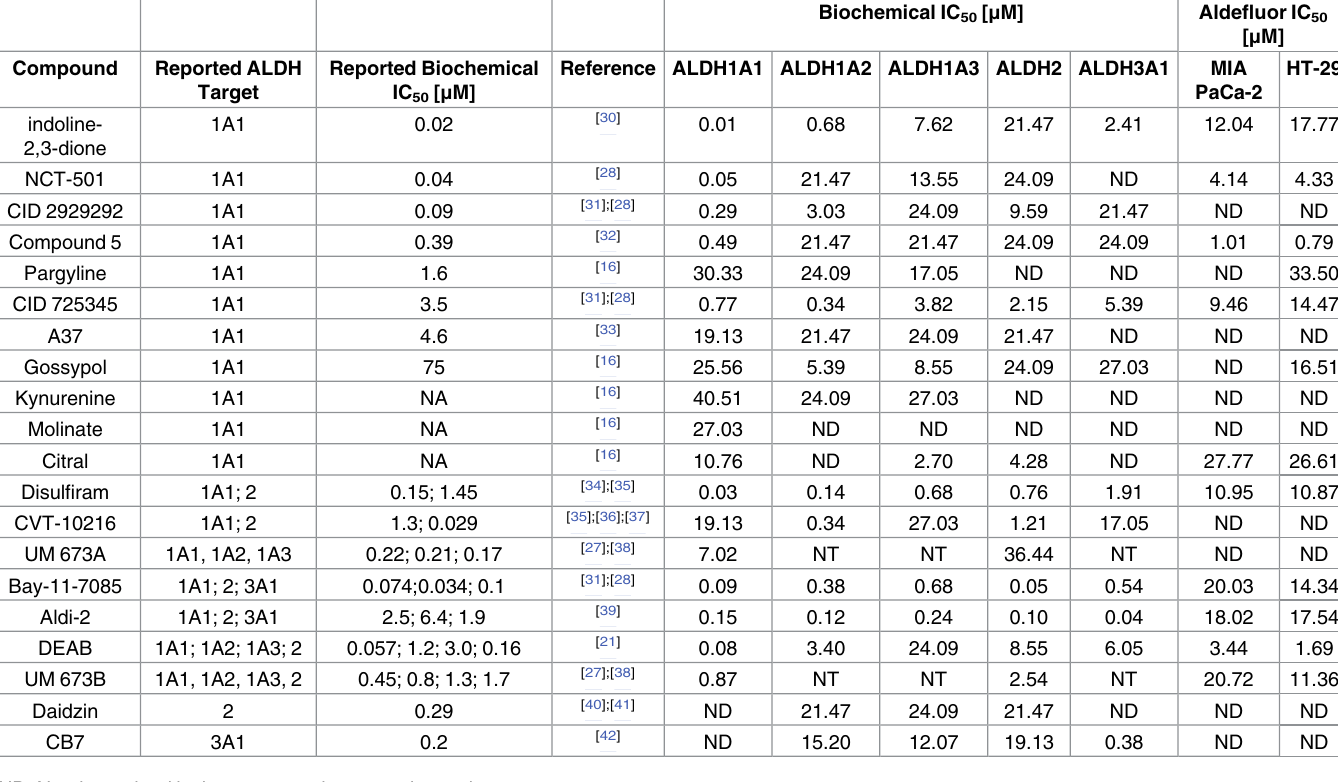
Table 1. IC 50 values of validation set compounds in biochemical and cell-based